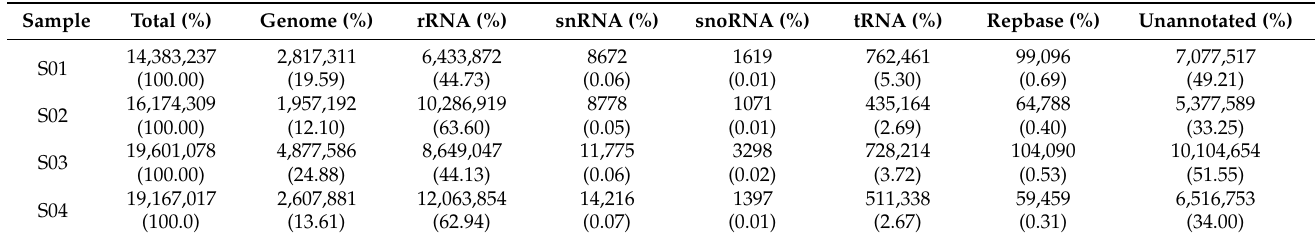
Table 2. sRNA classification annotation statistics.